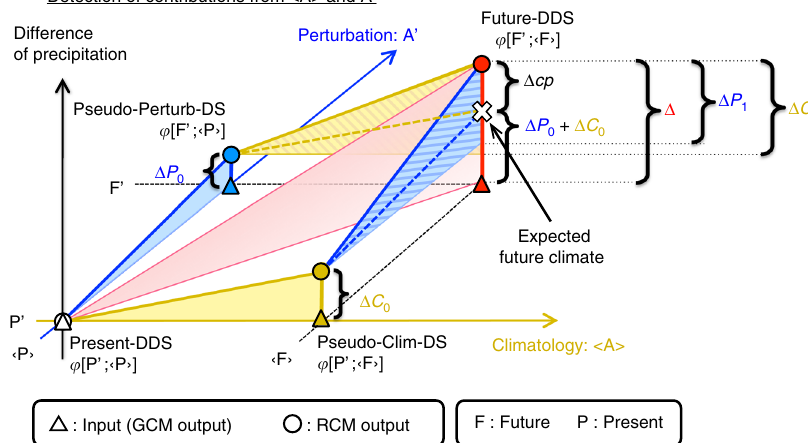
Fig. 1 Diagram of impact assessment due to changes in climatology and perturbation. The triangles and circles indicate the boundary conditions and corresponding RCM outputs for each experiment, respectively. Δ is the future precipitation change estimated using the direct dynamical downscaling (DDS) method. Δ P and Δ C represent the contributions of changes in the perturbation and climatology, respectively. The expected climate change is de fi ned by the sum of Δ P 0 and Δ C 0 . Δ cp is the difference between the actual and expected future